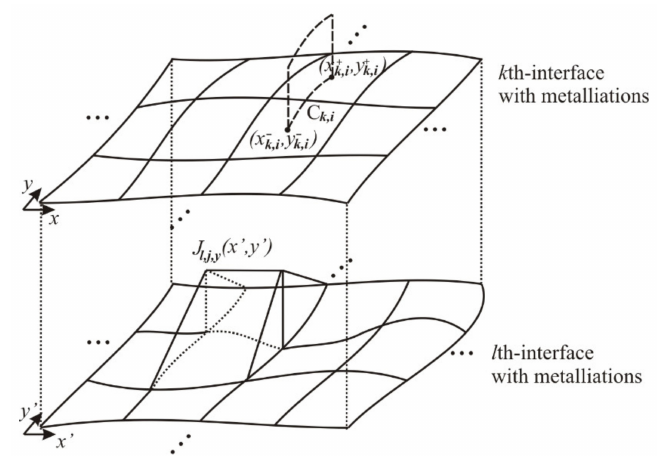
Figure 2. Y -component of j th generalized rooftop BF defined on two adjacent B é zier patches of the discretized layout hosted in the l th-interface with metallizations, and y -component k th-razor blade and isoparametric curved line C k , i which joins the center points of two adjacent B é zier patches of the of the discretized layout hosted in the kth-interface with